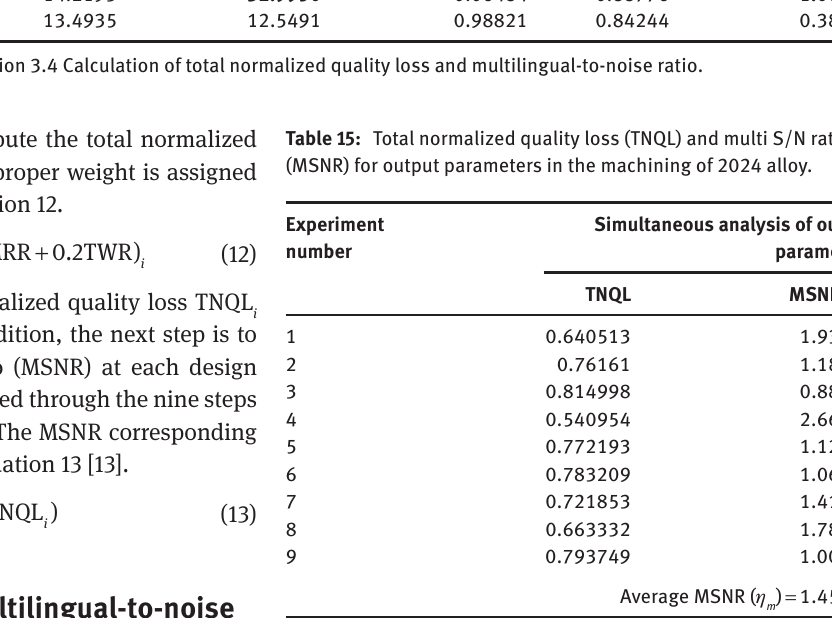
Table 16: Total normalized quality loss (TNQL) and multi S/N ratios (MSNR) for output parameters in the machining of Al/5%Al